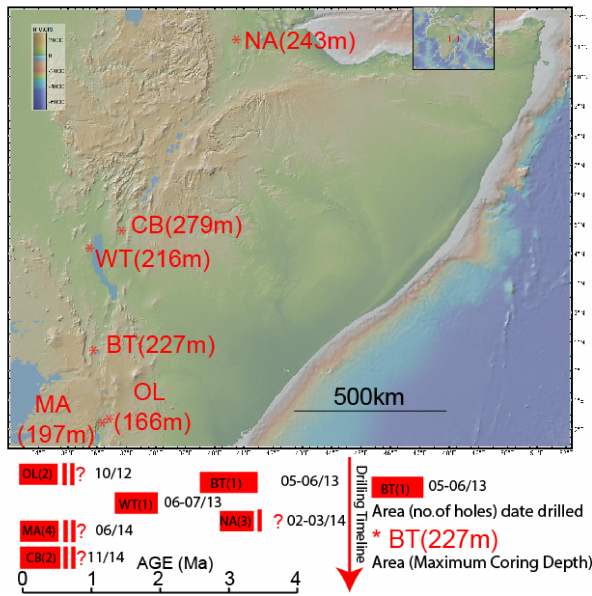
Figure 1. Map of eastern Africa showing locations of the HSPDP drilling areas; maximum coring depth for the deepest borehole in red on the map (the BT(227m) example indicates the maximum depth, 227m, that was reached at the BT site). The timeline be- low the map shows the number of cored boreholes, drilling dates, and approximate time intervals covered by the drill cores from each area. From north to south: NA: Northern Awash; CB: Chew Bahir; WT: West Turkana; BT: Baringo Tugen Hills; OL: Olorge- sailie/Koora Plain; and MA: Lake Magadi. Base map generated from GeoMapApp ©